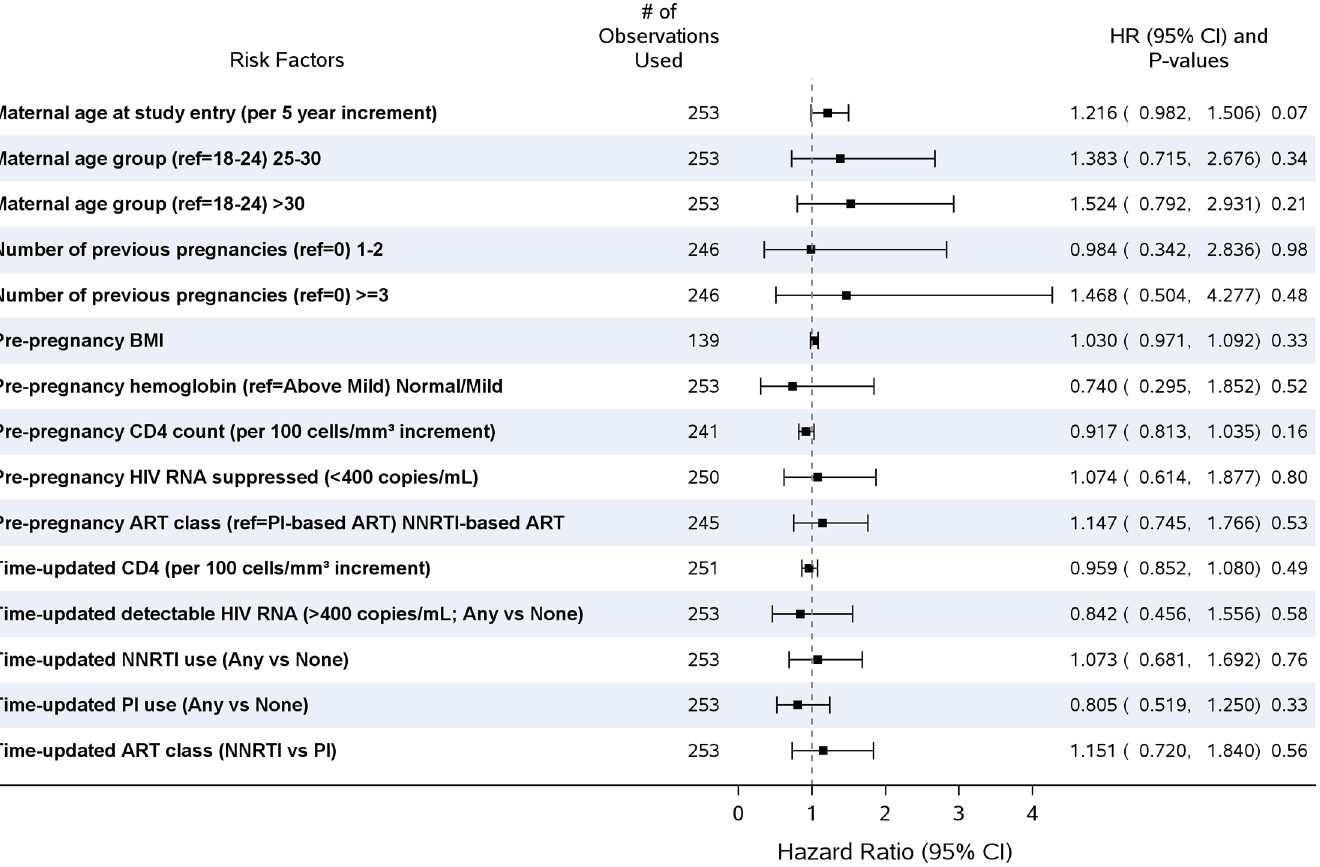
Fig 1. Cox proportional hazard models of time to non-live birth pregnancy outcomes (adjusted for region and parent study).